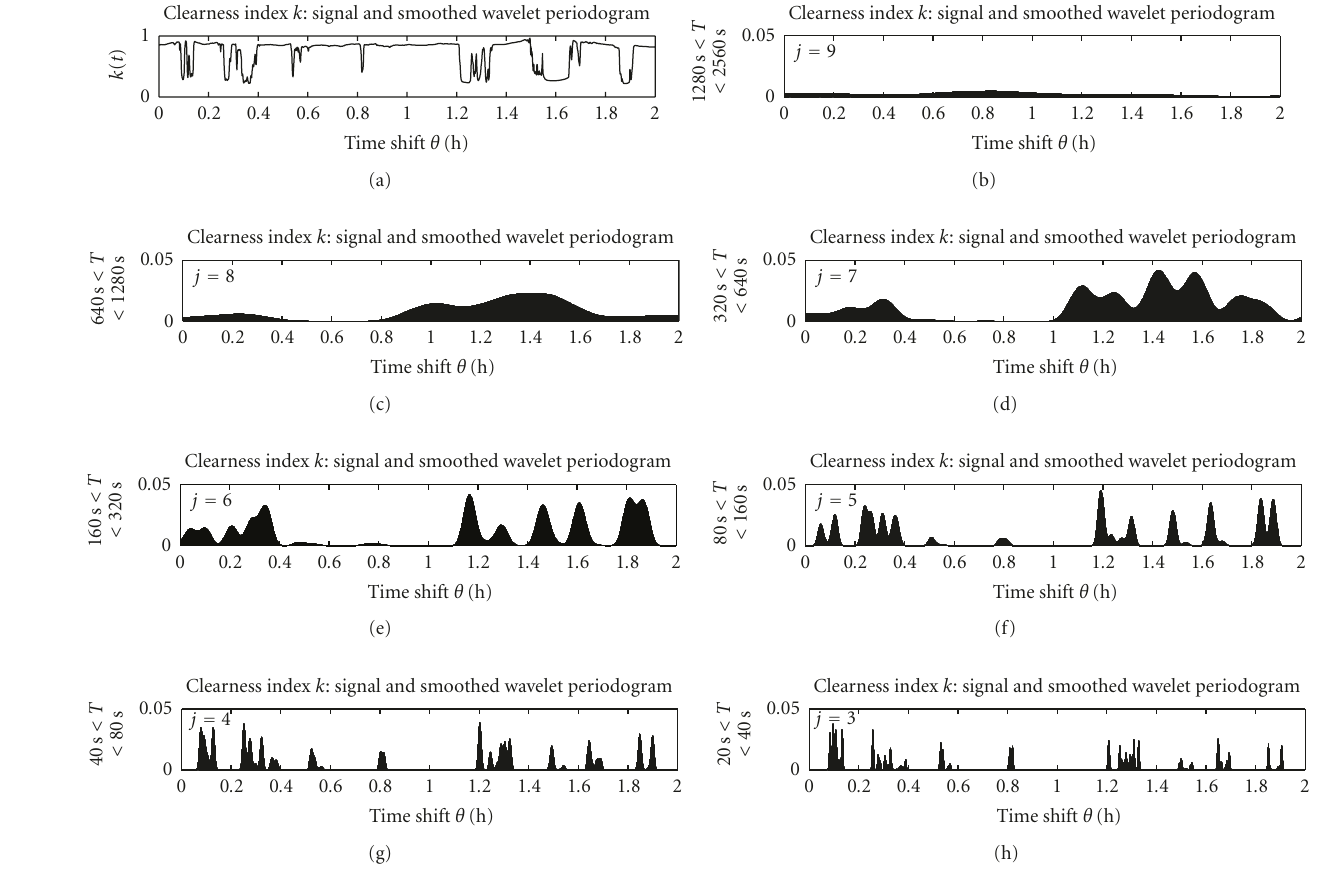
Figure 2: Smoothed wavelet periodogram of a time series of the instantaneous clearness index; θ = ν Δ T with Δ T = 5 seconds, j 0 = 12, N = 4096, shown are only j = 3 up to 9 during 2 hours, ψ : Haar